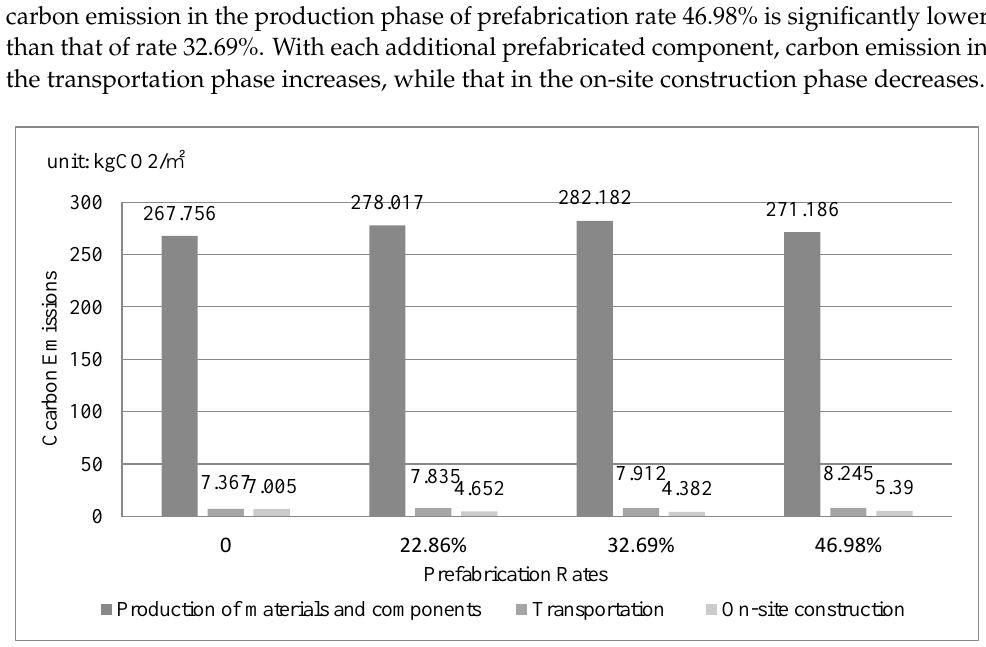
Figure 5. Carbon Emissions in Each Phase under Different Prefabrication